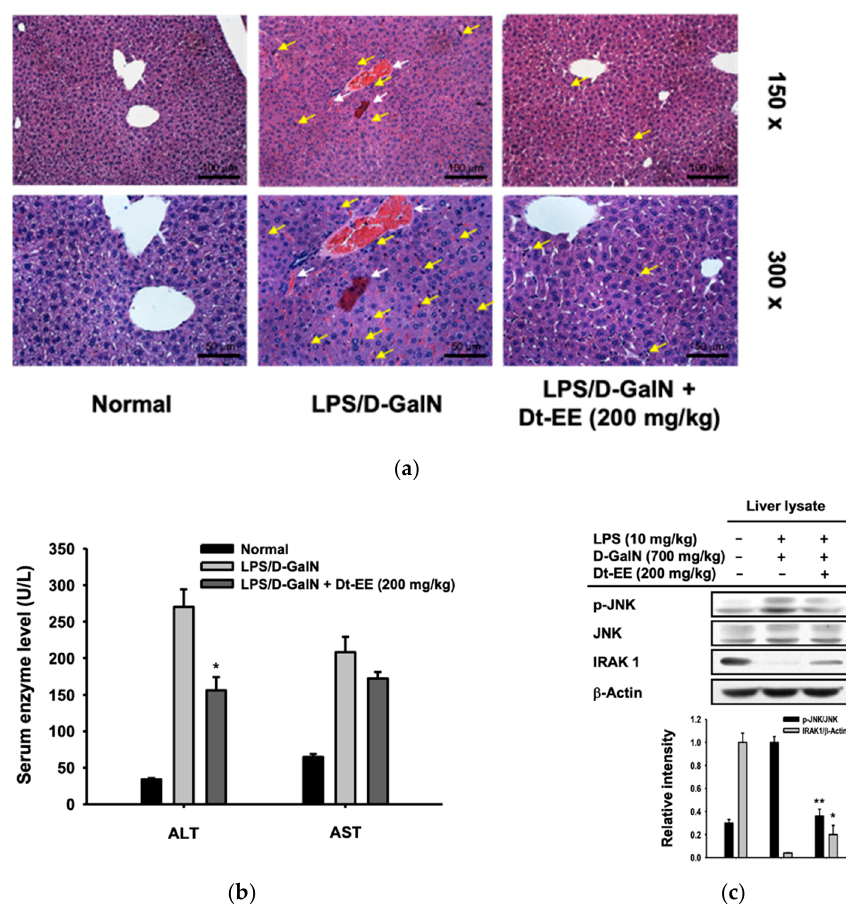
Figure 4. Effect of Dt-EE in a mouse model of LPS/D-GalN-induced hepatitis. ( a ) Histological analysis was conducted by H&E staining experiment with the liver tissues of LPS/D-GalN-induced mice. Mice livers were excised and stained with hematoxylin and eosin (150× and 300×). White arrows indicate bleeding and yellow arrows indicate neutrophilic recruitment. (150×–Scale bar: 100 µm, 300×–Scale bar: 50 µm). ( b ) The expression levels of serum enzymes, ALT and AST, were measured using a Roche Modular spectrophotometric autoanalyzer. ( c ) The total and phospho- protein levels of JNK and IRAK1, and β -actin were determined by an immunoblotting analysis using liver lysate from mice with induced hepatitis with and without Dt-EE treatment (200 mg/kg). *: p < 0.05 and **: p < 0.01 compared to the induced group.